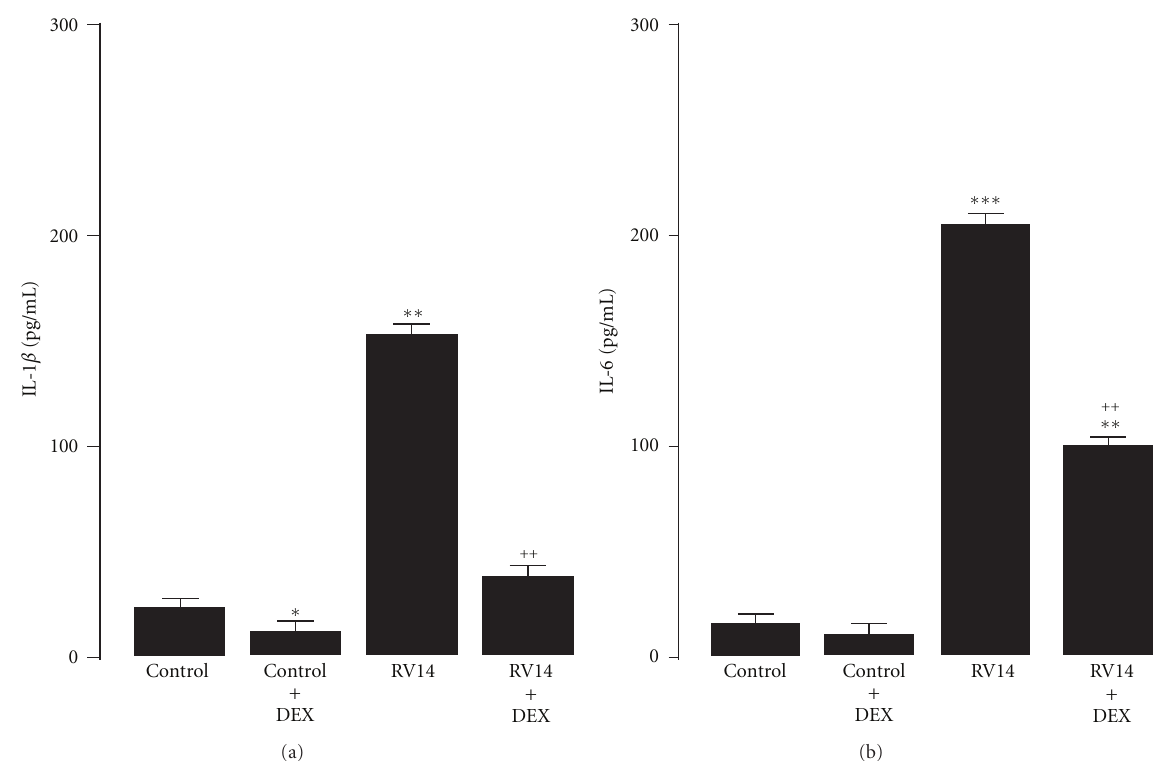
Figure 5: E ff ects of dexamethasone (DEX, 1 μ M) on release of IL-1 β (a) and IL-6 (b) in supernatants after type 14 rhinovirus (RV14), or sham (control) infection. E ff ects of DEX were examined at maximal production of each cytokine after RV14 infection. Results are reported as means ± S.E.M. from 7 samples. Significant di ff erence from corresponding control values are indicated by ∗ P < 0.05, ∗∗ P < 0.01, ∗∗∗ P < 0.001. Significant di ff erence from RV infection alone are indicated by ++ P < 0.01 (Cited from